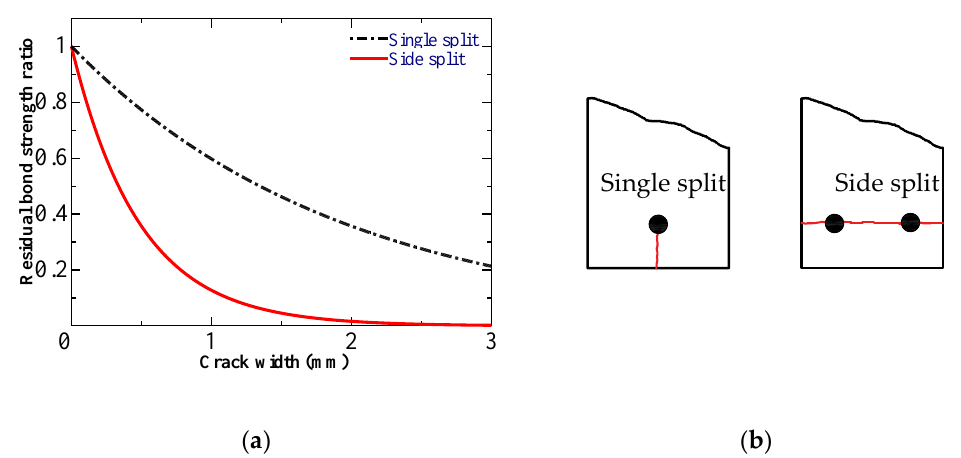
Figure 2. Effect of induced cracked pattern on bond deterioration [26]: ( a ) degradation of bond due to induced cracks; ( b ) induced crack pattern.